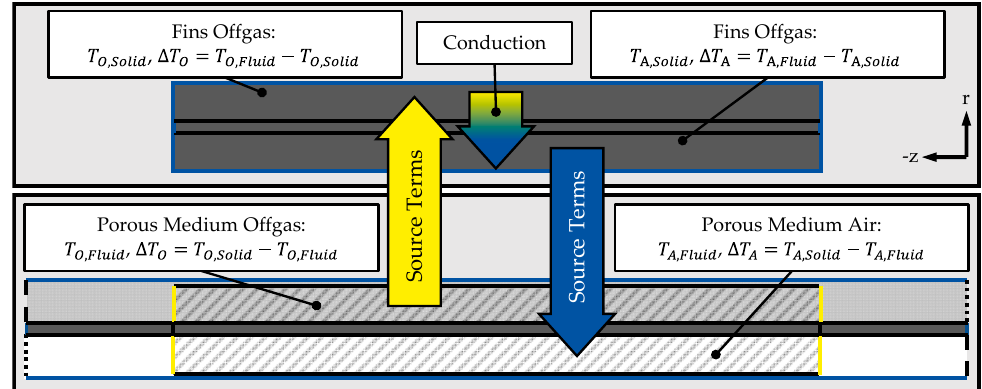
Figure 15. Schematic cross-section of the simplified simulation model. Figure 15. Temperature definitions and the resulting heat fluxes in the simplified simulation